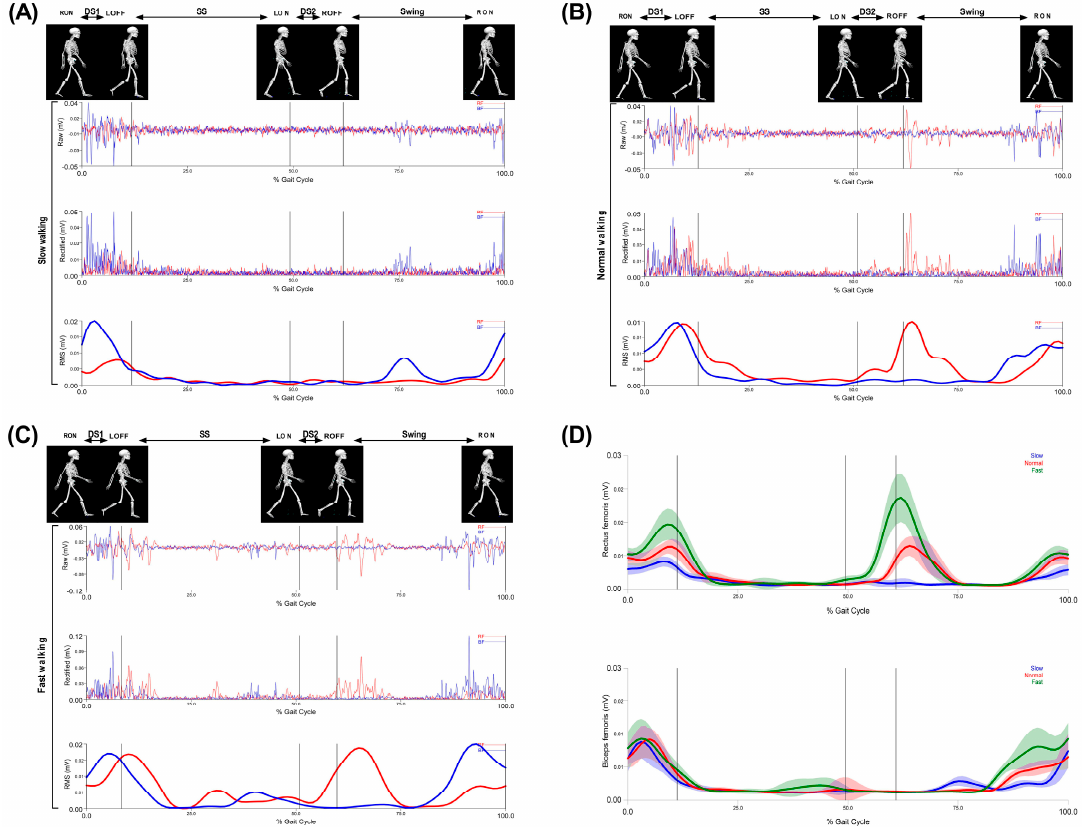
Figure 4. Walking phases: first double support (DS1), single support (SS), second double support (DS2), and swing of the rectus femoris (RF) and biceps femoris (BF). First raw signal; EMG raw data, second raw signal; EMG rectified data and third raw signal; and EMG RMS during ( A ) slow walking, ( B ) normal walking, and ( C ) fast walking. ( D ) Muscle activity amplitude of the three speeds of rectus femoris and biceps femoris.